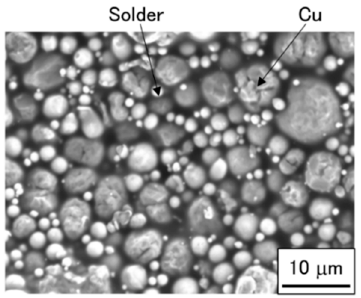
Figure 1. SEM image of Cu-solder-resin composite paste.